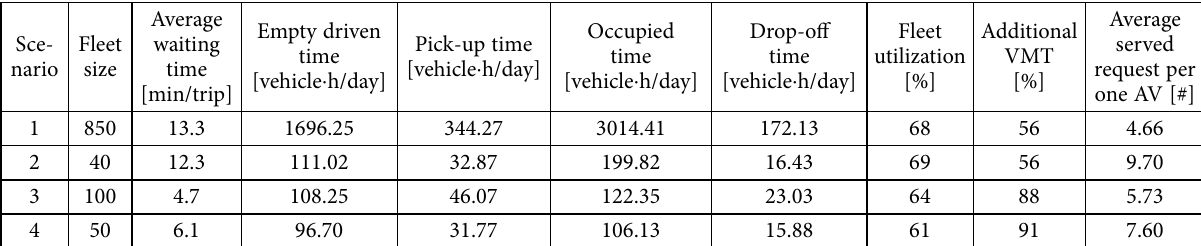
Table 3. The travellers’ trip time components when the fleet size of AVs is 10% of the sample size